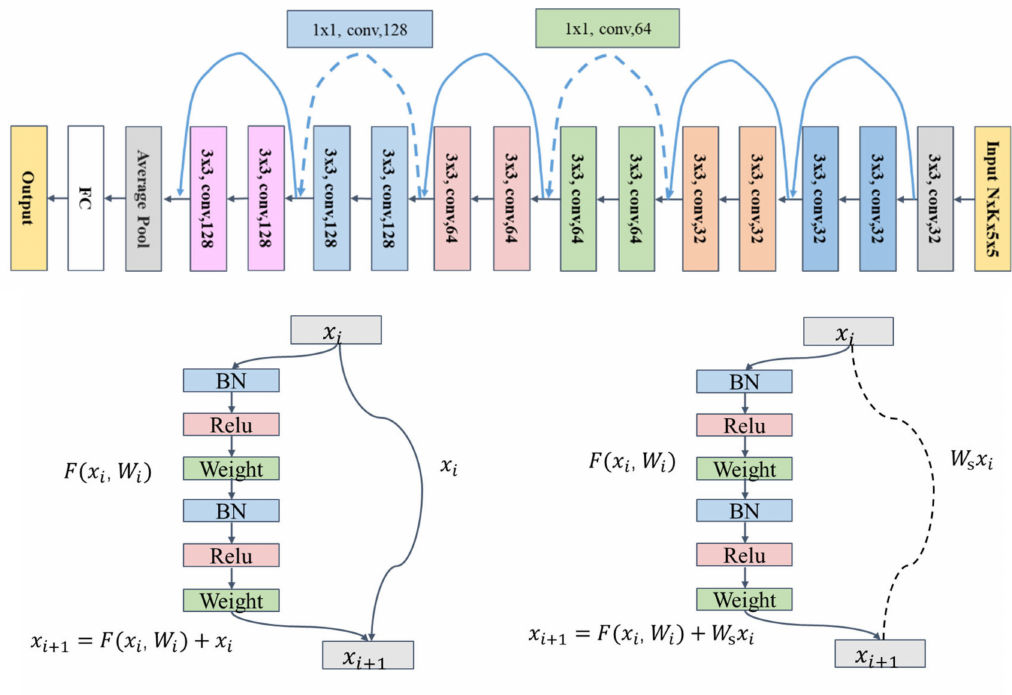
Figure 4. LM-ResNet model